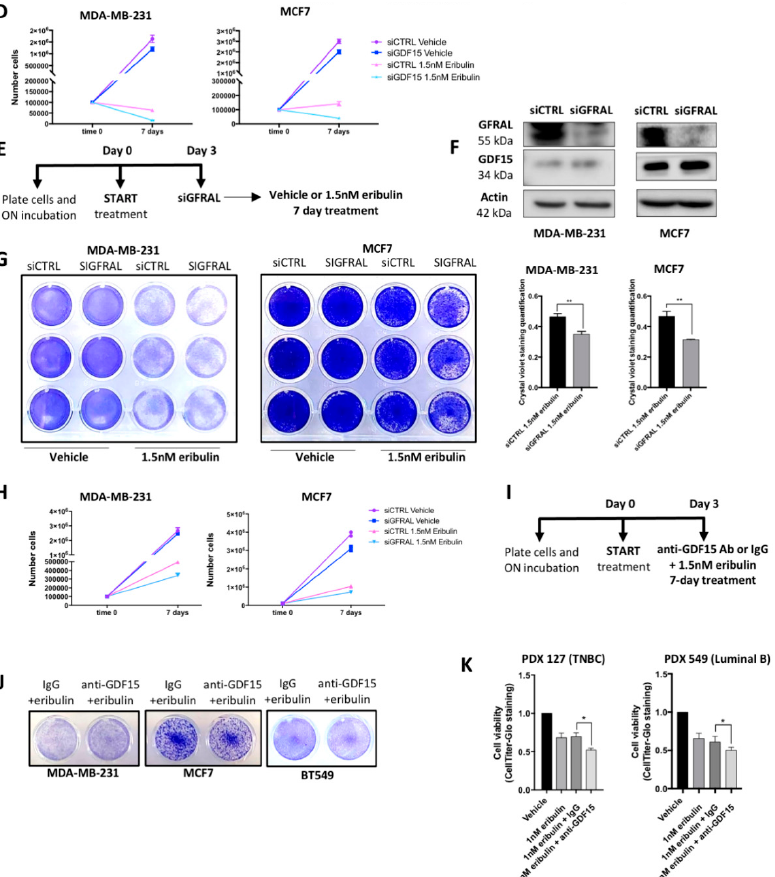
Figure 5. GDF15 contributes to the maintenance of the DTP state in cells responding to eribulin. ( A ) Schematic representation of siGDF15 experiment and following 7-day eribulin treatment. ( B ) WB analysis of GDF15 protein in siCTRL and siGDF15 cells. Normalization was carried out with Actin as a loading control. ( C ) Representative image of crystal violet staining in siCTRL and siGDF15 cells treated for 7 days with the vehicle and 1.5 nM eribulin treatment. Graphs (right panel) show the quantification of cell viability in siGDF15 cells during eribulin treatment compared with siCTRL cells. ** p -value < 0.01, **** p -value < 0.0001. ( D ) Cell-counting experiment performed in siCTRL and siGDF15 cells after a 7-day vehicle and 1.5 nM eribulin treatment. The graphs show higher sensitivity to eribulin of siGDF15 cells compared with siCTRL cells. The graph for each cell line shows the mean viable cell number ± SD calculated from three independent experiments. ( E ) Schematic representation of siGFRAL experiment and following 7-day eribulin treatment. ( F ) WB analysis of GFRAL and GDF15 protein in siCTRL and siGFRAL cells. Normalization was carried out with Actin as a loading control. ( G ) Representative image of crystal violet staining in siCTRL and siGFRAL cells treated for 7 days with the vehicle and 1.5 nM eribulin treatment. Graphs (right panel) show the quantification of cell viability in siGFRAL cells during eribulin treatment compared with siCTRL cells. ** p -value < 0.01. ( H ) Cell-counting experiment performed in siCTRL and siGFRAL cells after a 7-day vehicle and 1.5 nM eribulin treatment. The graphs show higher sensitivity to eribulin of siGFRAL cells compared with siCTRL cells. The graph for each cell line shows the mean viable cell number ± SD calculated from three independent experiments. ( I ) Schematic representation of anti-GDF15 Ab treatment in combination with 1.5 nM eribulin for 7 days. ( J ) Representative images of crystal violet staining in MDA-MB-231, MCF7 and BT549 cell lines treated for 7 days with vehicle, eribulin, eribulin + IgG and eribulin + anti-GDF15 Ab. * p -value < 0.05. ( K ) Graphs of cell viability quantification using CellTiter-Glo staining in PDXO treated for 7 days with vehicle, eribulin, eribulin + IgG and eribulin + anti-GDF15